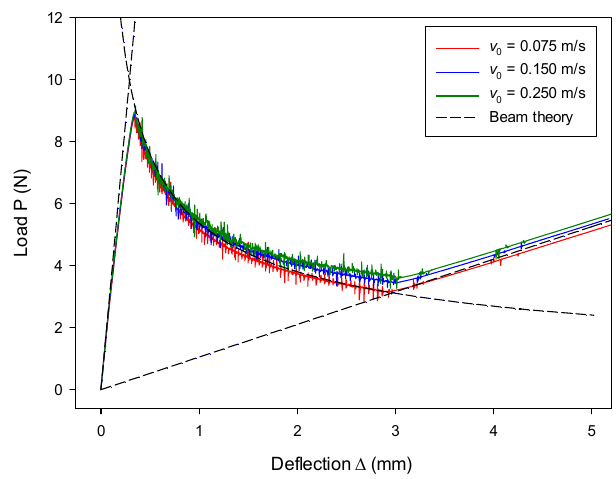
Figure 13. Loading rate effect on load–deflection relation.